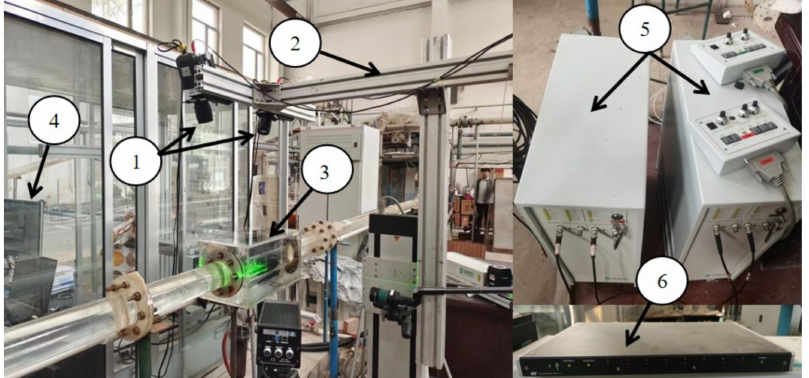
Figure 5. Particle image velocimetry system: 1—CCD camera; 2—coordinate frame; 3—square water jacket; 4—DynamicStudio software; 5—laser;